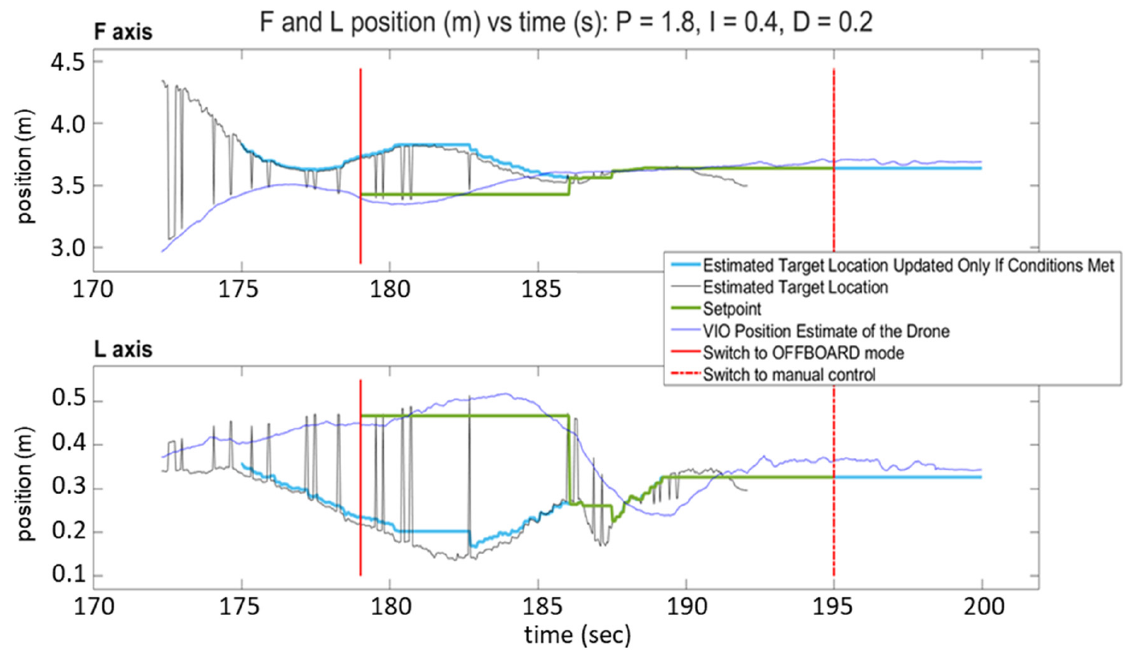
Figure 14. SVGS automated landing experiment 2: position vs. time for F and L axes. The plots have four traces each: the VIO estimate of the drone’s position (blue), the target location estimated by SVGS (black), the landing position set point (green), and the estimated target location, updated only if drone velocity conditions are met (light blue).